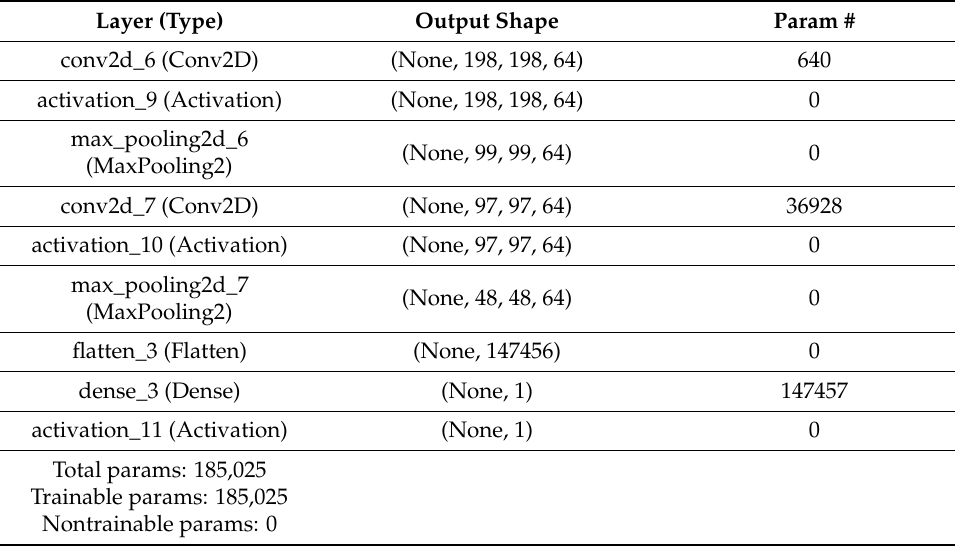
Table 1. Summary of convolutional neural network for binary classification.